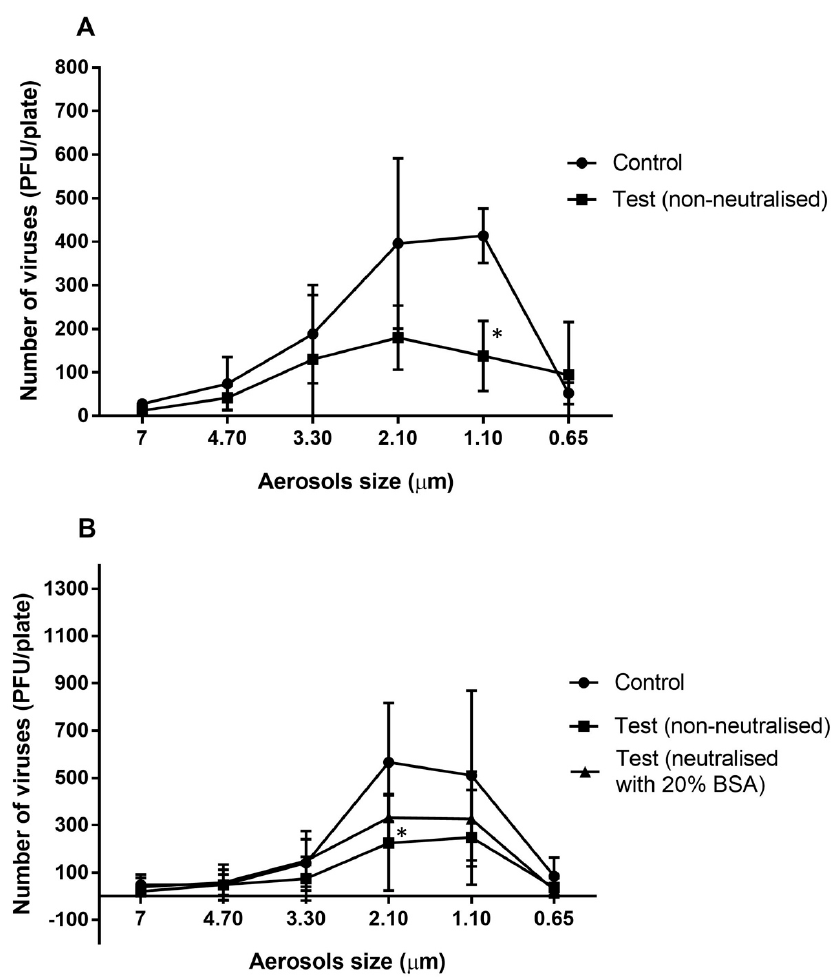
Figure 1. Number of murine hepatitis viral cells (MHV-1) recovered from different aerosol sizes with or without neutralisation of the vaporised essential oils for 10 min ( A ) or 20 min ( B ). The antimicrobial gel significantly (*) reduced the ability of viral aerosols to infected A9 cells in aerosols sizes of 2.10 and 1.10 µm compared to the untreated control ( p = 0.011). Data points represent the mean (±95% confidence interval) of three independent experiments. BSA = bovine serum albumin. After allowing the essential oils to vaporize for 20 min, there was a significant 53% reduction in the number of viable aerosolized viral particles compared to the control ( p = 0.001; Table 2). Following use of 20% BSA, the activity of the vapours of the essential oils was slightly but not significantly ( p = 0.078; Table 2) reduced, resulting in a 33% reduction in the viability of viral aerosols compared to control ( p = 0.001; Table 2)